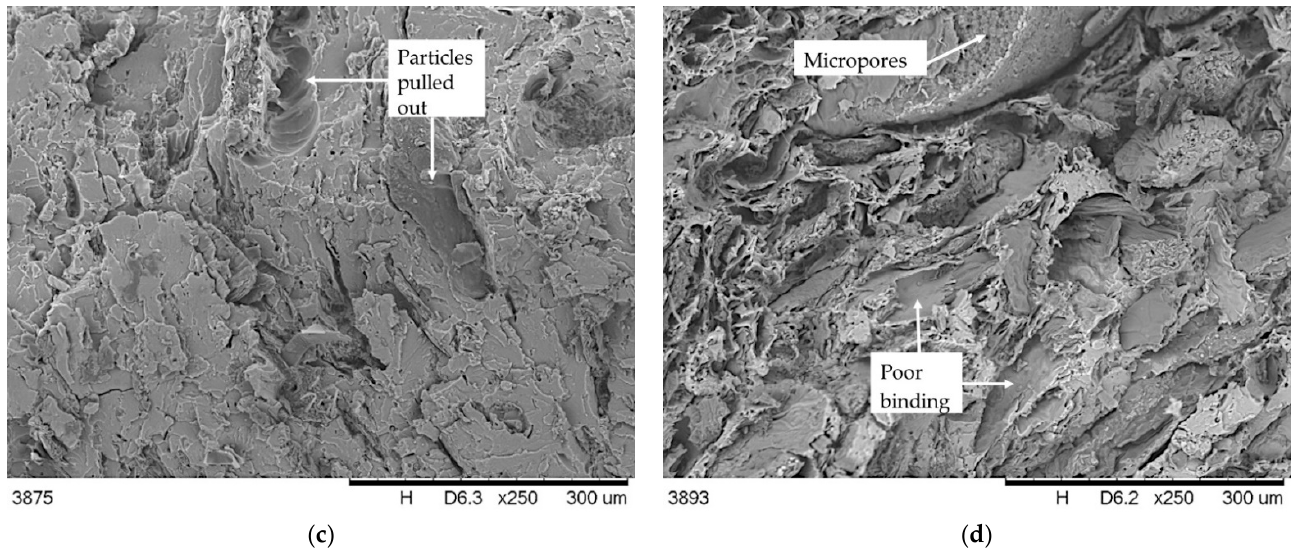
Figure 7. SEM microphotographs of PVC ( a ) and PVC containing hop residue: ( b ) PVC/10 H, ( c ) PVC/20 H, ( d ) PVC/30 H.